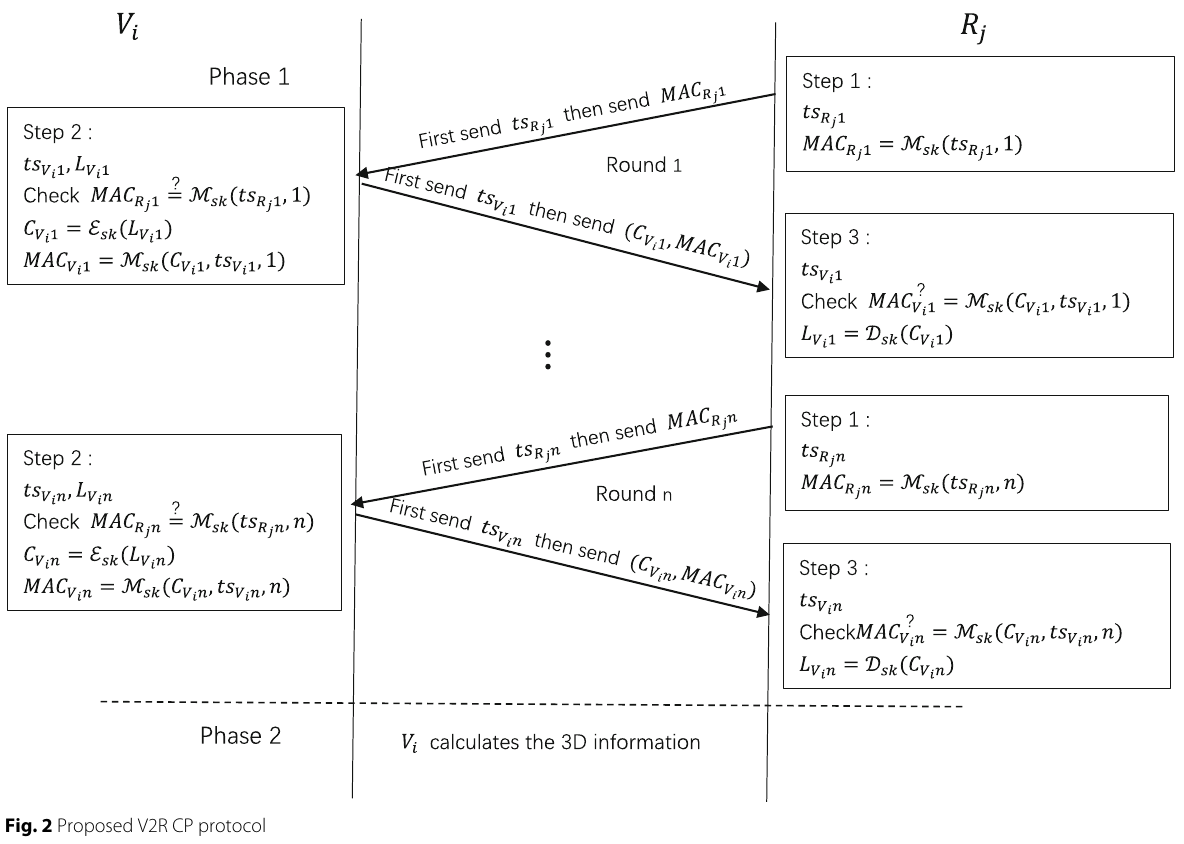
Fig. 2 Proposed V2R CP protocol